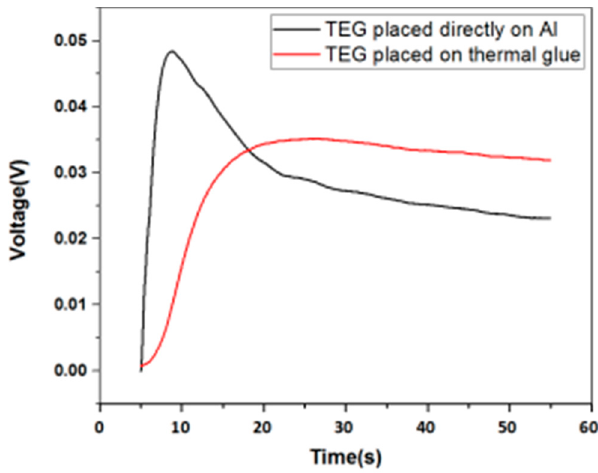
Figure 3. Open circuit voltages of TEG with the hot side placed directly on Al and on thermal glue.